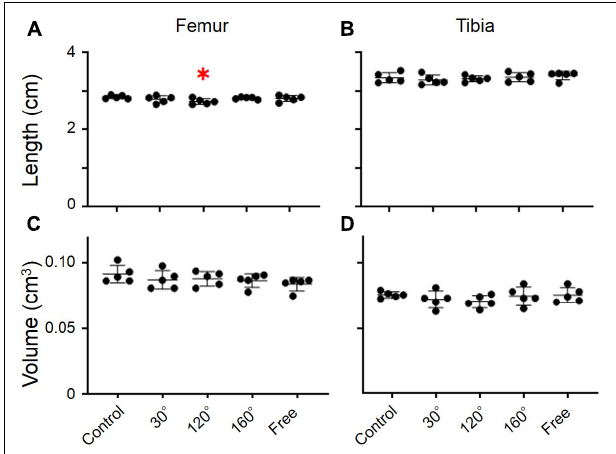
FIGURE 3 | Lengths and volumes of femur and tibia. (A) Femoral length, (B) tibial length, (C) femoral volume, and (D) tibial volume [Mean ± standard deviation (SD), ∗ p < 0.05 vs. the control group, one-way analysis of variance (ANOVA)].